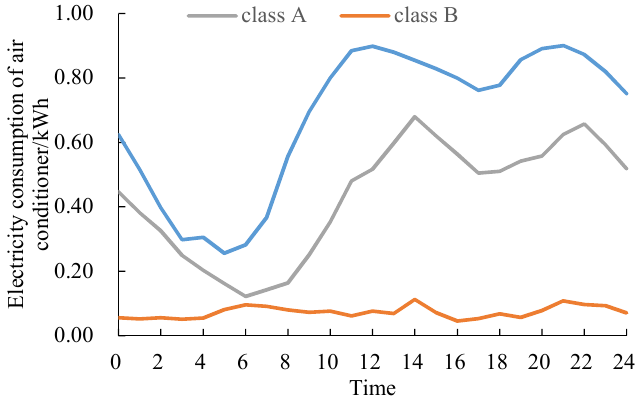
Figure 4. Air conditioning load curve of di ff erent Table 1. Daily load rate.